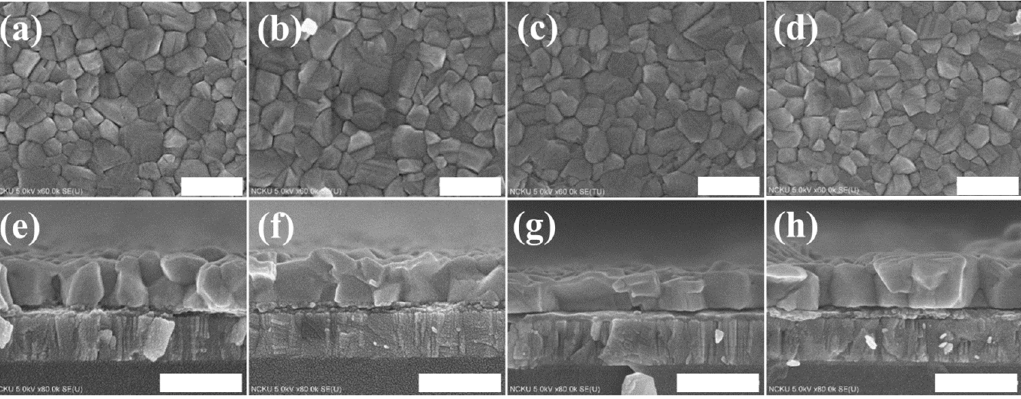
Figure 5. Plane and cross-section SEM images, respectively, of MAPbI 3 on PbI 2 with ( a , e ) 2% water, ( b , f ) 2% water + KI (4 mg / mL) ( c , g ) 2% water + KBr (1 mg / mL), and ( d , h ) 2% water + KCl (2 mg / mL). (Scale bar = 500 nm).